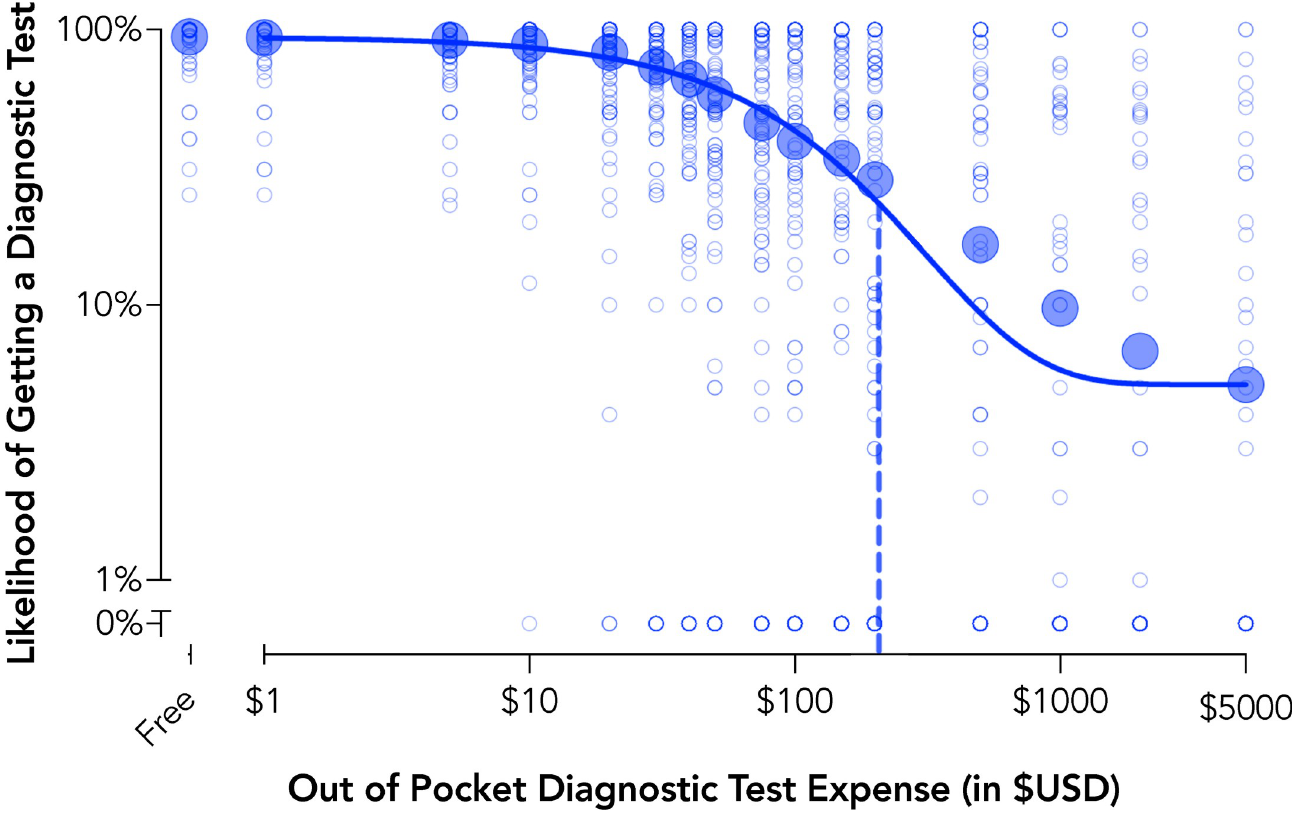
Fig 4. Behavioral economic demand for diagnostic testing (Experiment 4). Plotted are group mean data and individual data points for behavioral economic demand of diagnostic testing recorded on the hypothetical purchase task. Demand curve data are plotted using the exponential demand function [54]. The dotted line is the price representing shifts from inelastic or price insensitive to elasticity or price sensitive demand (P max ).